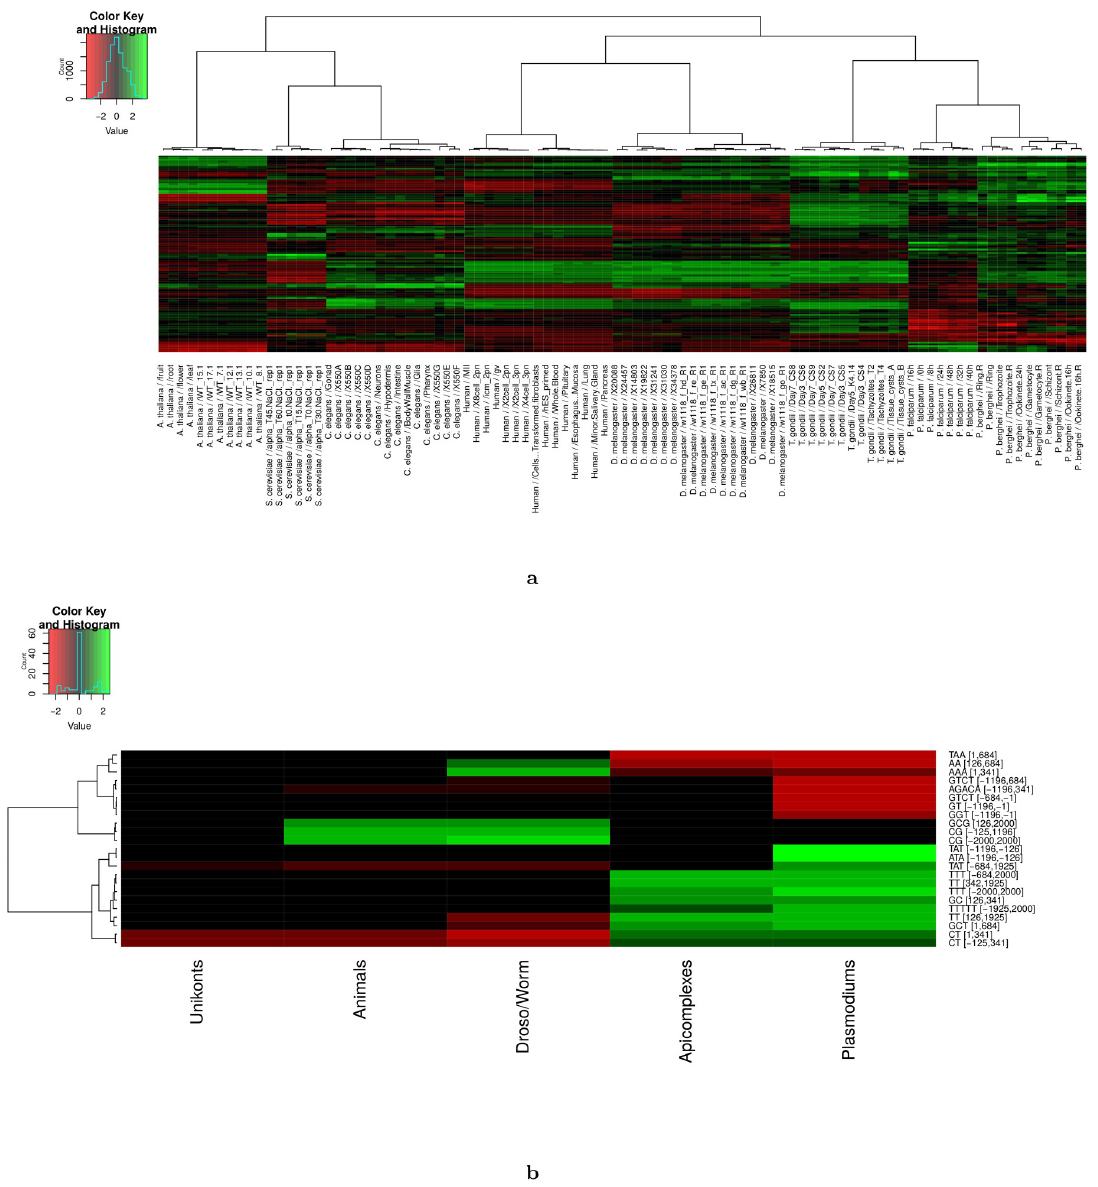
Fig 6. Conservation of long regulatory elements along evolution. The 10 most important variables of each species and conditions were identified and collected, and their correlations with expression were computed for every species and conditions. Correlations were then normalized by conditions (i.e. correlations were divided by the standard deviation of all correlations computed for the condition) to get the same range of values for each condition. a A hierarchical clustering (Ward’s criterion) was run to classify the conditions according to these correlations. b The heatmap represents the variables whose correlation with expression is conserved at the level of at least one of five different taxa. The variables that do not show conservation of correlation at any of the 5 taxa have been removed for